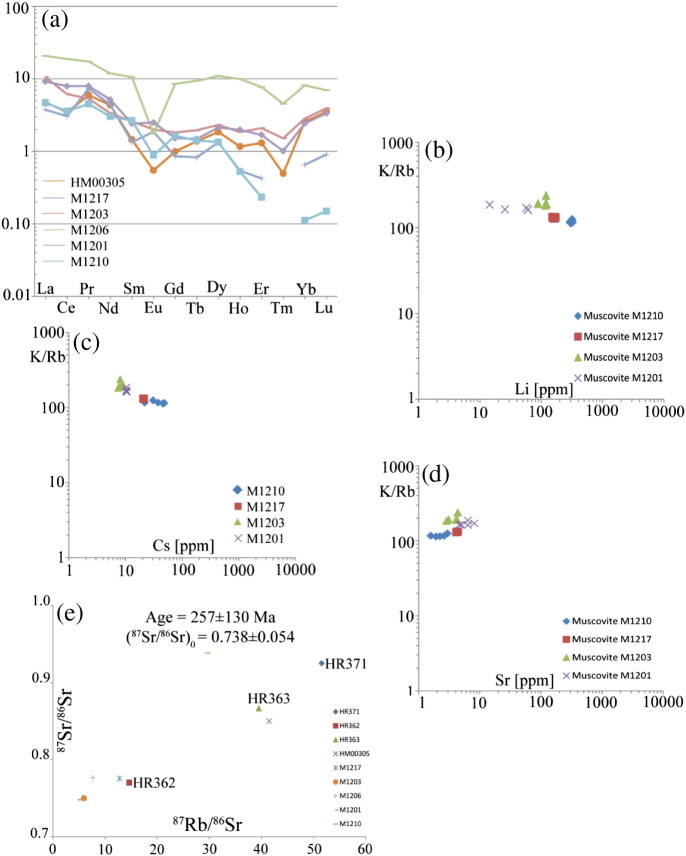
Compositional characteristics of Permian pegmatites and magmatic muscovites. (a) Chondrite-normalised REE pattern of the pegmatites (CI-values from Sun & McDonough, 1989), (b) K/Rb vs Li, (c) K/Rb vs Cs and (d) K/Rb vs Sr of the muscovites and (e) Rb–Sr whole rock data of the pegmatites. Data labelled HR371, HR362 and HR363 are from Haas (1985).